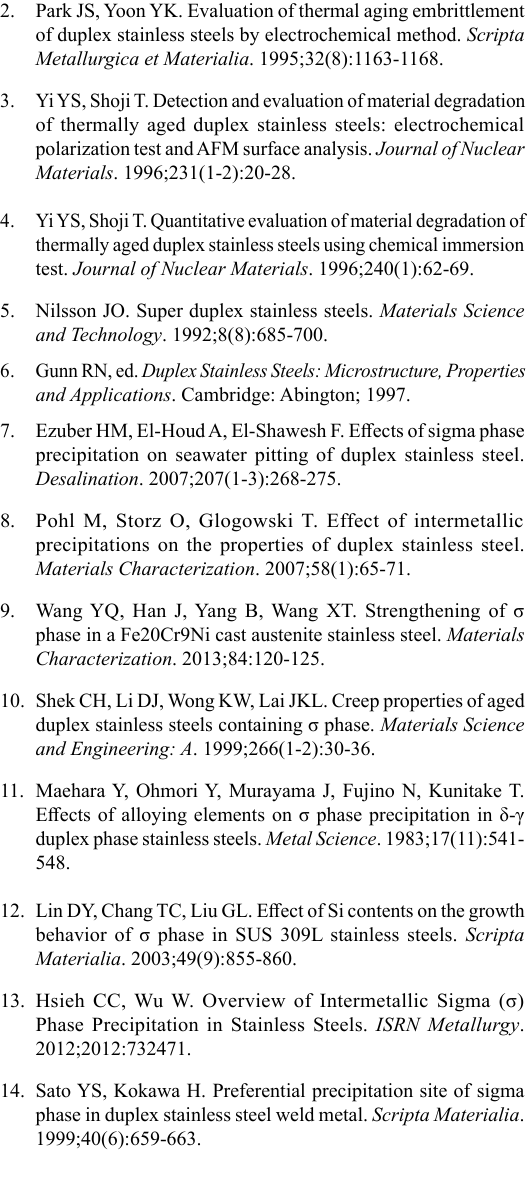
Figure 8. Cr content in Z3CN20.09M specimens with different